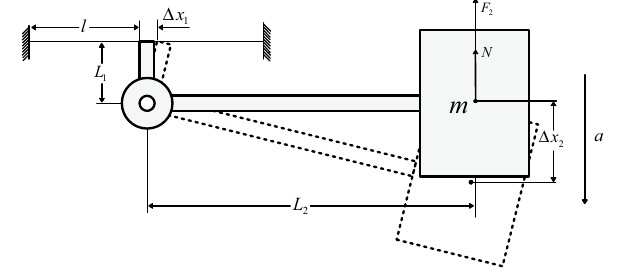
Figure 2. Structural vibration